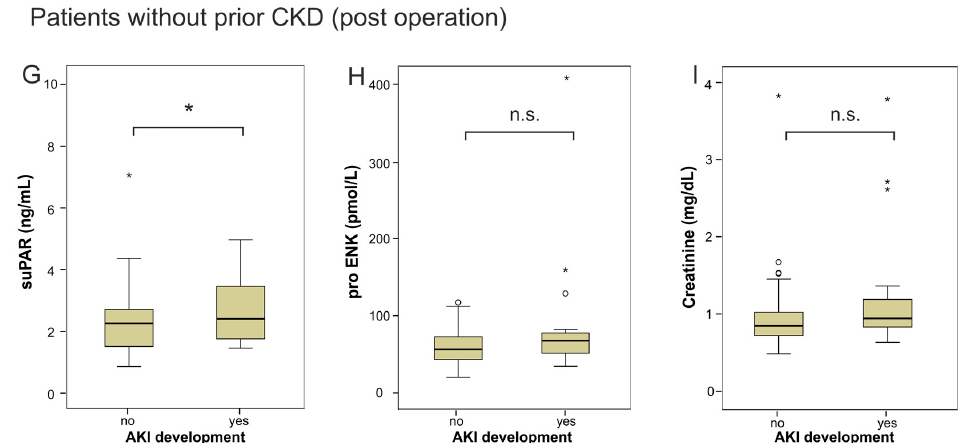
Figure 1. Serum concentrations of different biomarkers for AKI before surgery. ( A ) Serum suPAR levels were determined by enzyme linked immunoassay (ELISA) and revealed significantly higher levels at baseline for patients developing AKI within four days after surgery than patients without AKI. ( B ) Serum proENK levels were significantly elevated in patients with AKI after surgery. ( C ) In contrast, serum creatinine levels were not different between the two groups. ( D – F ) Serum levels of suPAR, proENK and creatinine of patients before cardiac surgery, excluding patients with the diagnosis of chronic kidney disease (CKD) such as diabetic nephropathy. ( G – I ) Serum levels of suPAR, proENK and creatinine immediately after cardiac surgery, excluding patients with chronic kidney disease. Box plot are displayed, where the bold line indicates the median per group, the box represents 50% of the values. The horizontal lines show minimum and maximum values of calculated non-outlier values; asterisks and open circles indicate outlier values (* p < 0.05, ** p < 0.01).